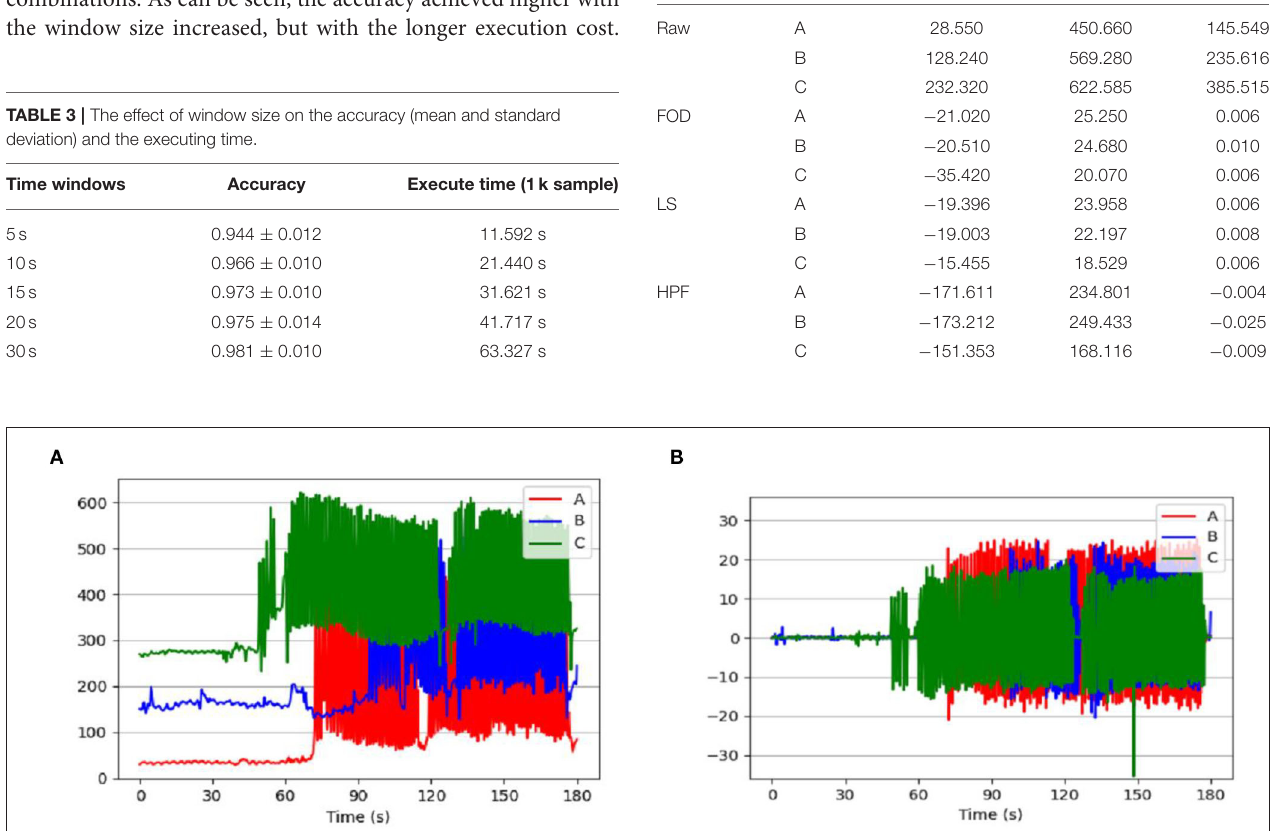
Frontiers in Veterinary Science |